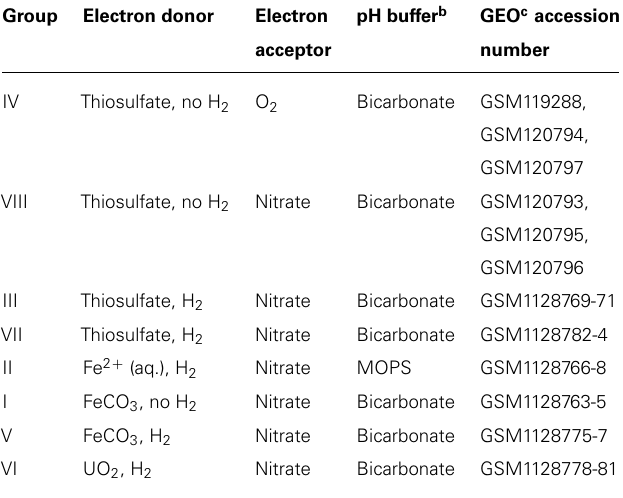
Table 1 | Exposure conditions for T. denitrificans cells used for gene expression microrrays a